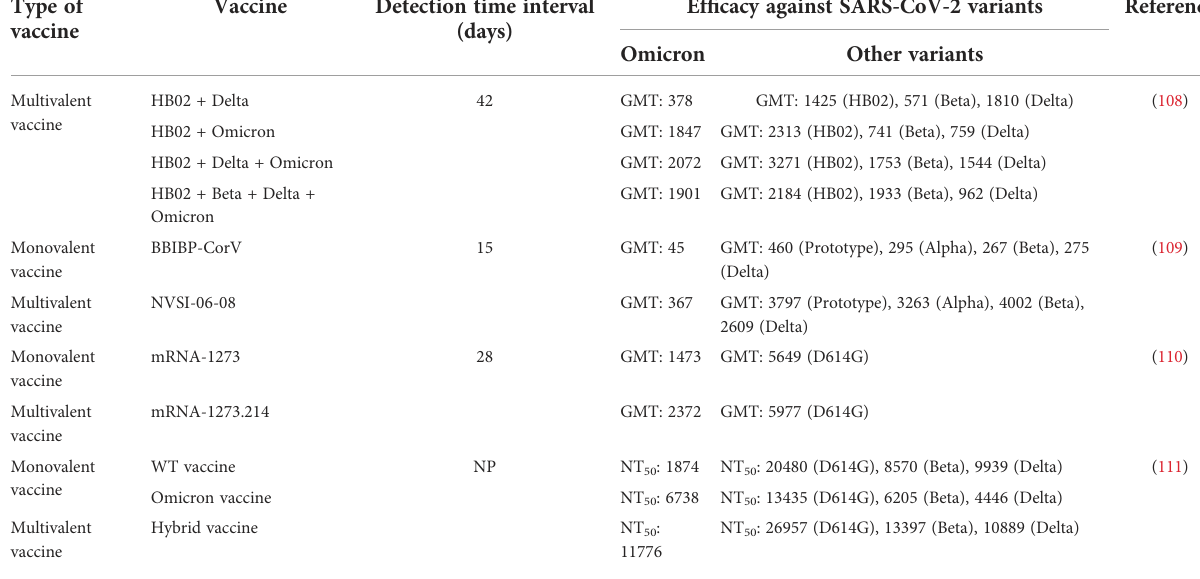
TABLE 4 Ef fi cacy of multivalent vaccine against SARS-CoV-2